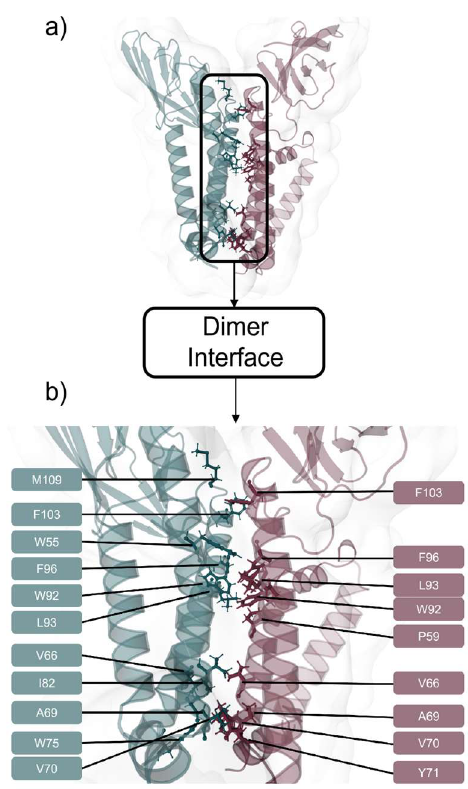
Figure 5. ( a ) SARS-CoV-2 M protein dimer via HADDOCK [44] prediction using TMHMM [34,35] based monomers with interfacial residues represented as sticks, and ( b ) interface zoom-in featuring interfacial residues identified with the color code of teal for Monomer A and garnet for Monomer B.